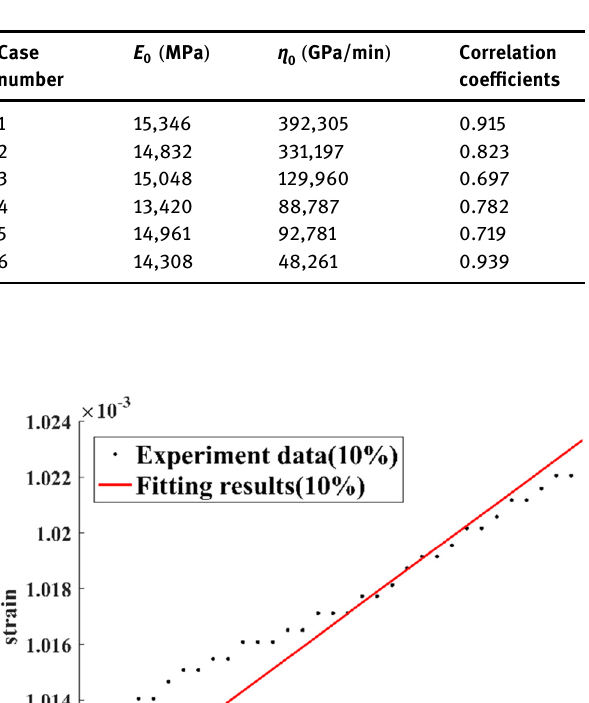
Table 5: Model parameters based on the conventional maxwell model